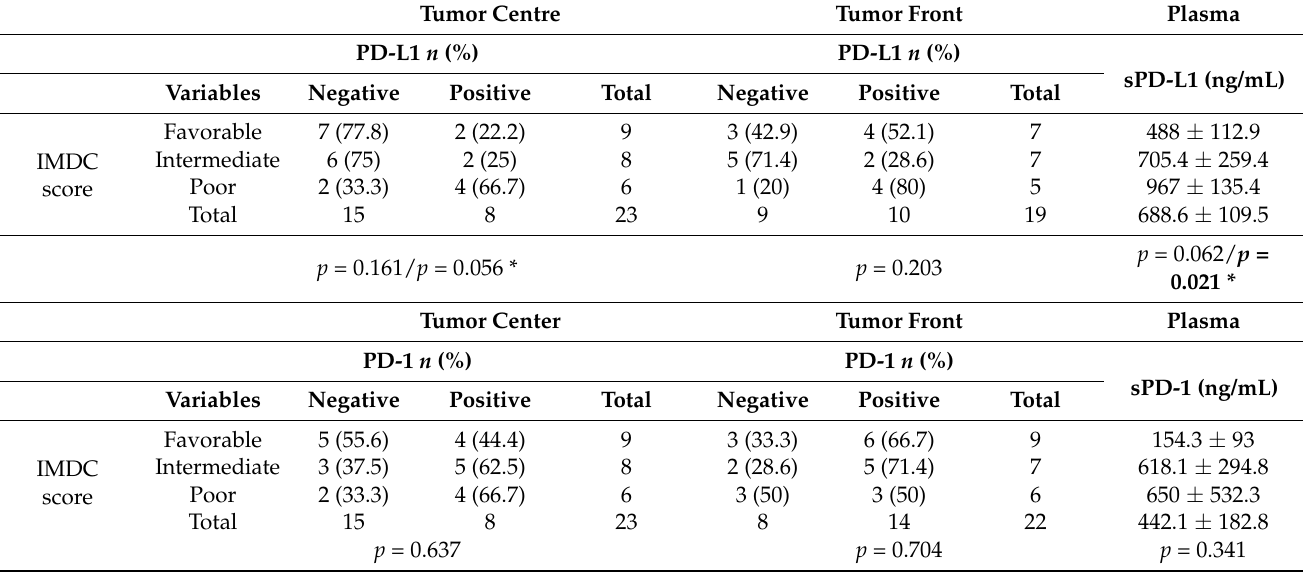
Table 5. PD-L1 and PD-1 expression and sPD-L1 and sPD-1 levels in the subgroup of metastatic CCRCC classified according to the International Metastatic Renal Cell Cancer Database Consortium (IMDC) score (* Favorable and Intermediate pooled together). Chi-x 2 , Mann-Whitney and Kruskal Wallis tests were used. Statistically significant values are highlighted in